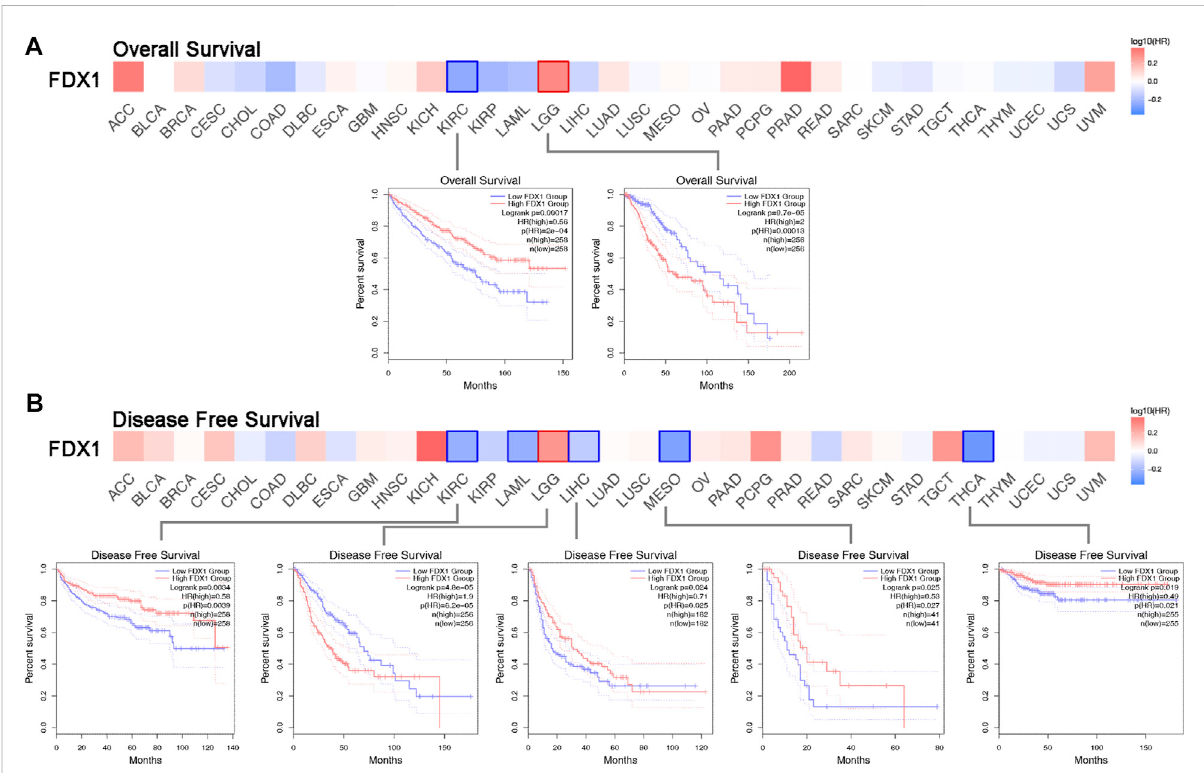
FIGURE 2 Survival hazard ratio between high and low FDX1 expression in multiple TCGA cancer types. (A) Signi fi cance map of the overall survival analysis based on FDX1 expression. The Kaplan-Meier survival curve depicts the signi fi cant survival contribution of FDX1 in KIRC and LGG. (B)